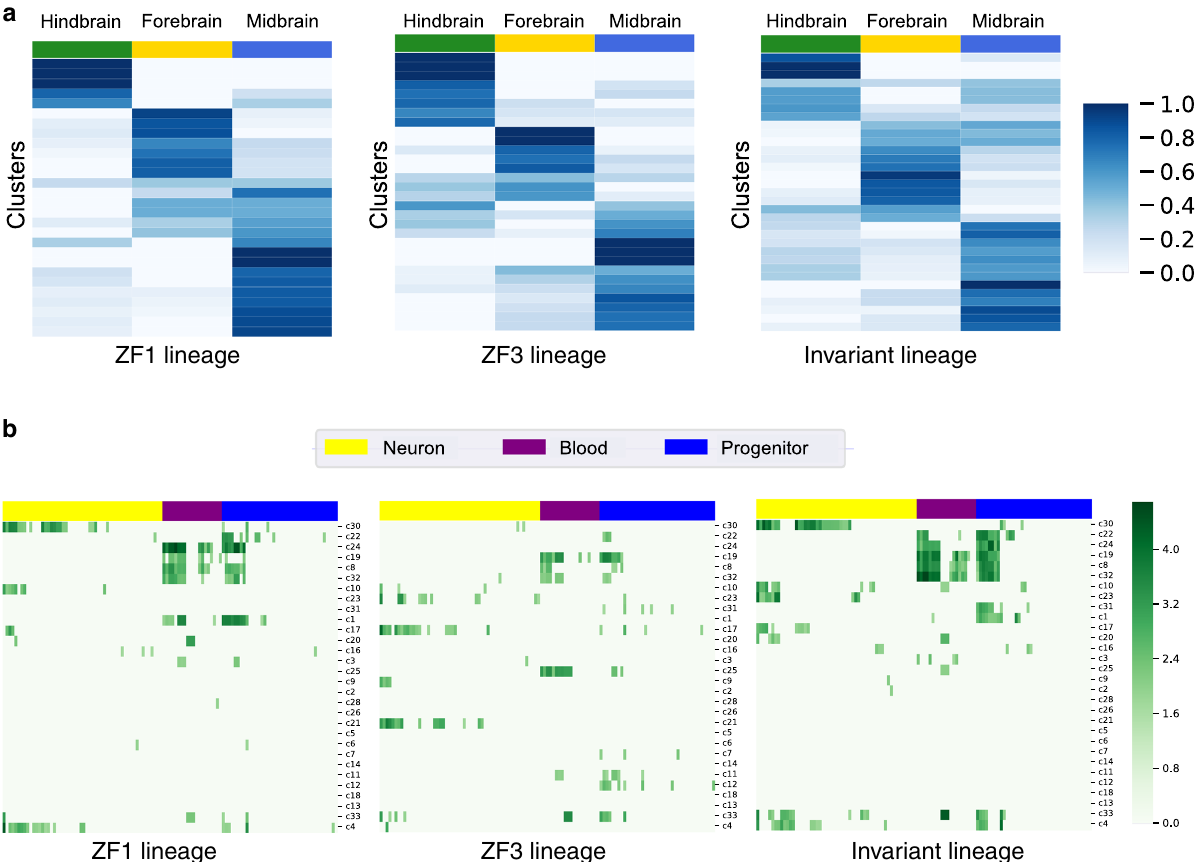
Fig. 5 Functional analysis of cell clusters for scGESTALT datasets. a Heat map of the distribution of cell clusters for each region of the brain (columns). Cell types were classi fi ed as belonging to the forebrain, midbrain or hindbrain, and the proportions of cells within each region were calculated for each cluster. Each row sums to 1. Region proportions were colored as shown in key. The leftmost panel shows the heat map for the clusters in ZF1 lineage (subsampled), middle panel shows the heat map for ZF3 lineage and the rightmost panel shows the heat map for the invariant lineage. b Heat map of the ffiffiffiffiffiffiffiffiffiffiffiffiffiffiffiffiffiffiffiffiffiffiffiffiffiffiffiffi p p -values ( , higher value means more signi fi cant) for GO terms for invariant clusters. Adjusted p -values for GO terms were obtained from g: (cid:1) log ð p value Þ Pro fi ler 46 . P -values are calculated using the hypergeometric distribution. P -values are adjusted using the g:SCS algorithm 49 . Rows represent invariant clusters and columns represent different GO terms (Supplementary Table 8). Yellow, purple and blue columns correspond to GO terms related to neurons, blood and progenitors respectively. The leftmost panel shows the heat map for ZF1, middle panel for ZF3 and the rightmost panel for the invariant tree. As can be seen, the invariant tree correctly combines the unique terms identi fi ed for each tree. On one hand, it is able to identify neuron clusters, which are well represented in ZF3 but not in ZF1. On the other hand, it is able to identify progenitor clusters which are not well represented in